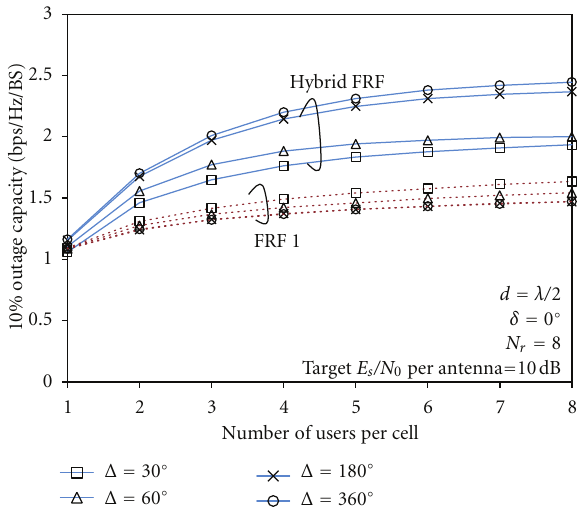
Figure 9: Cellular outage capacity with 10% outage